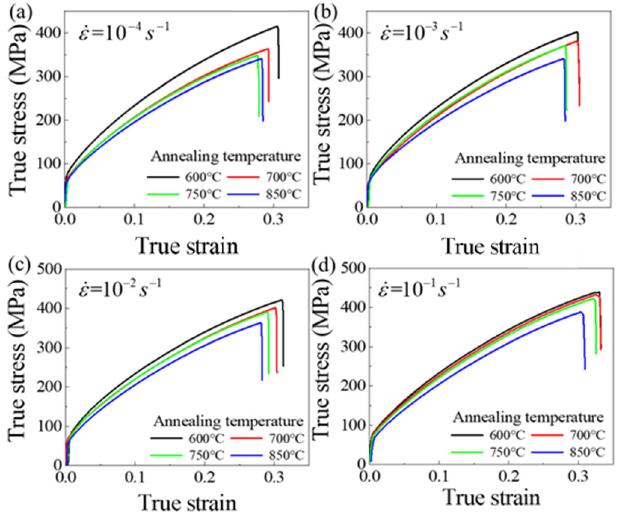
Figure 3. True stress–strain curves of specimens with various annealing conditions at: . ε = 10 − 4 s − 1 , ( b ) ( a )